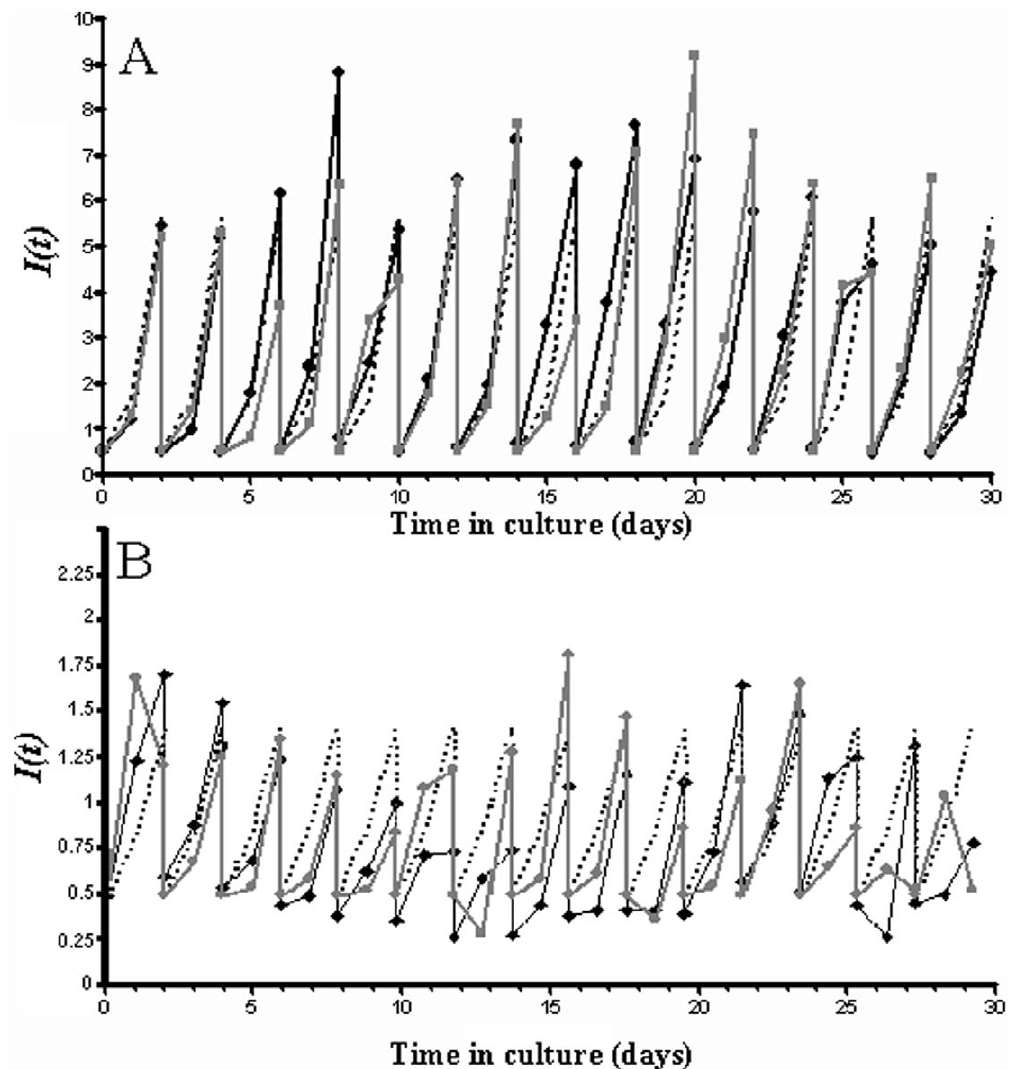
Figure 3. Course of the parasitaemia I(t). Daily samples in suspended (A) and static (B) long-term cultivation of P. falciparum- infected RBCs under standard conditions compared to the model predictions. Squares and grey solid line correspond to a culture with standard sub-cultivation protocol. Dotted line shows the simulated behaviour of automatized sub-cultivation with ratios. Black solid line shows the performance of real automatized